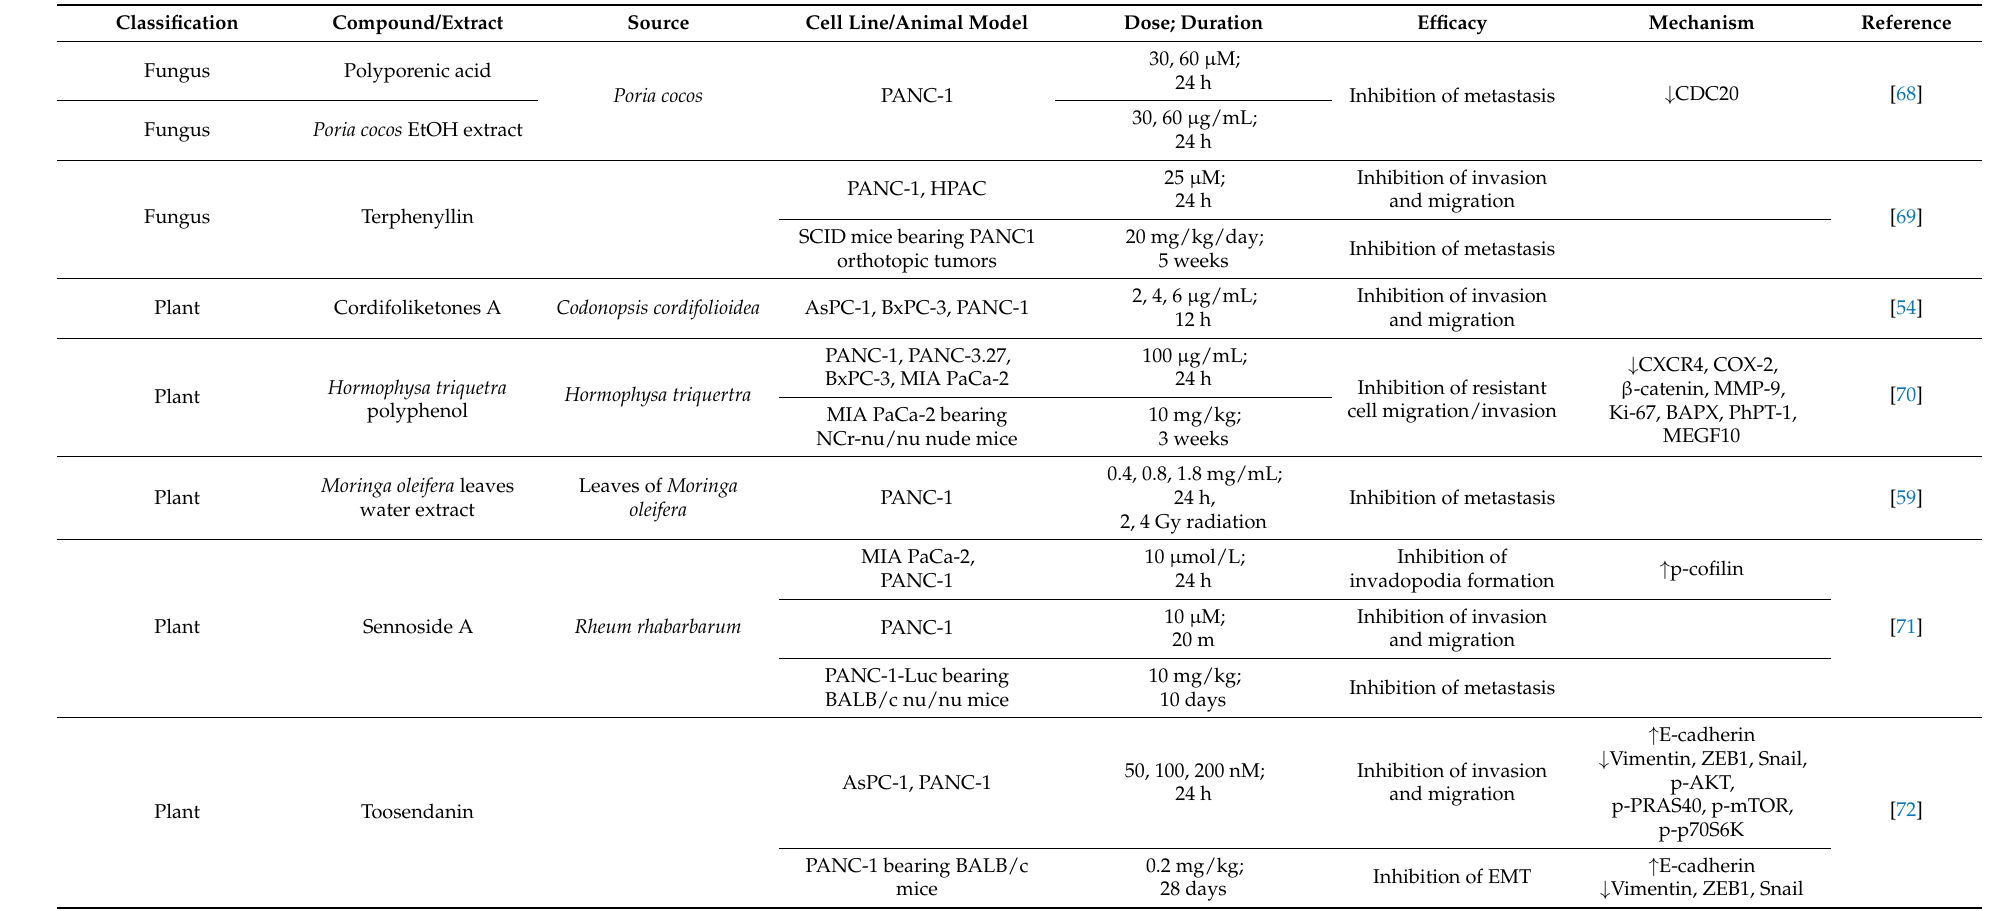
Table 4. Metastasis inhibiting natural